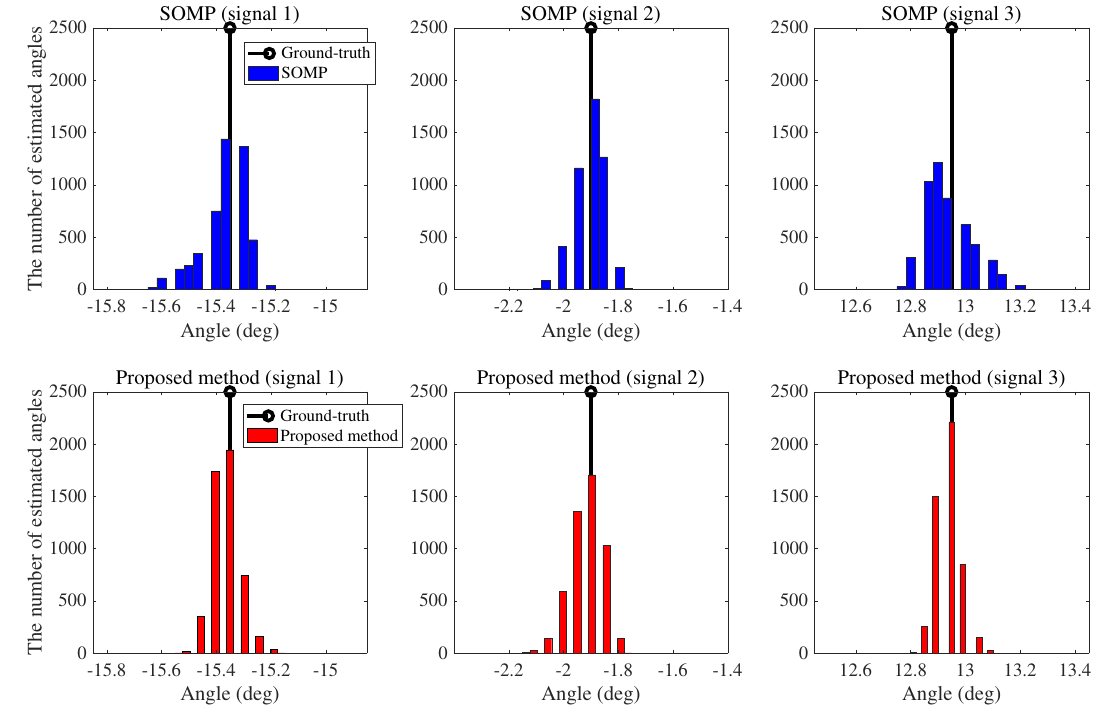
Figure 3. The histogram bar chart of DOA estimation results. Table 2. DOA estimation